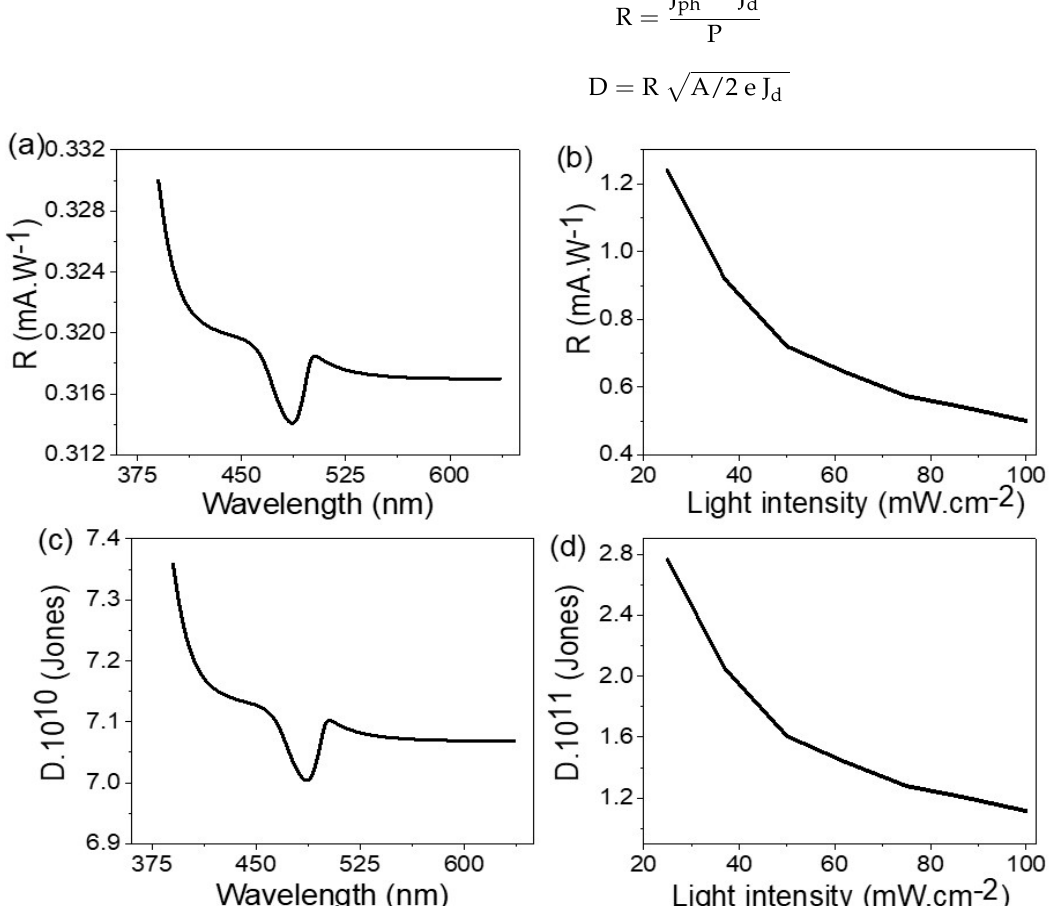
Figure 8. The responsivity value through relation with light ( a ) wavelengths and ( b ) intensity. The detectivity value through the relation with light ( c ) wavelengths and ( d ) intensity.